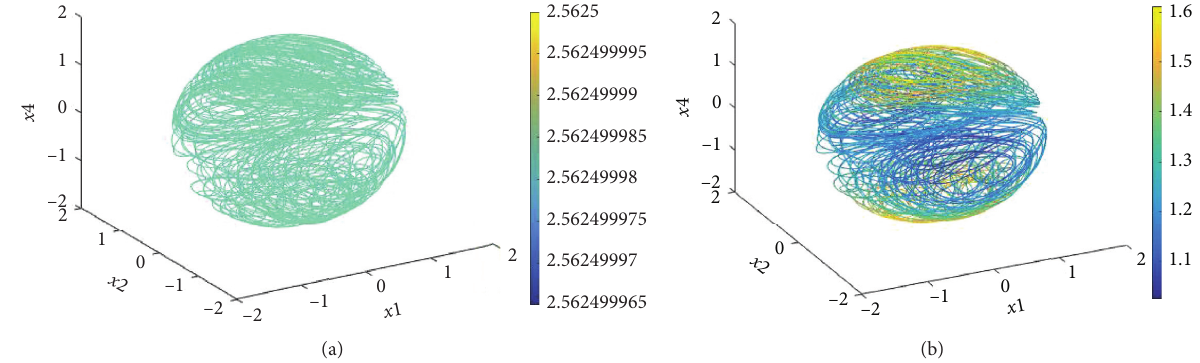
Figure 2: Chaotic orbits of Case 1 system. (a) Hamilton energy. (b) Casimir